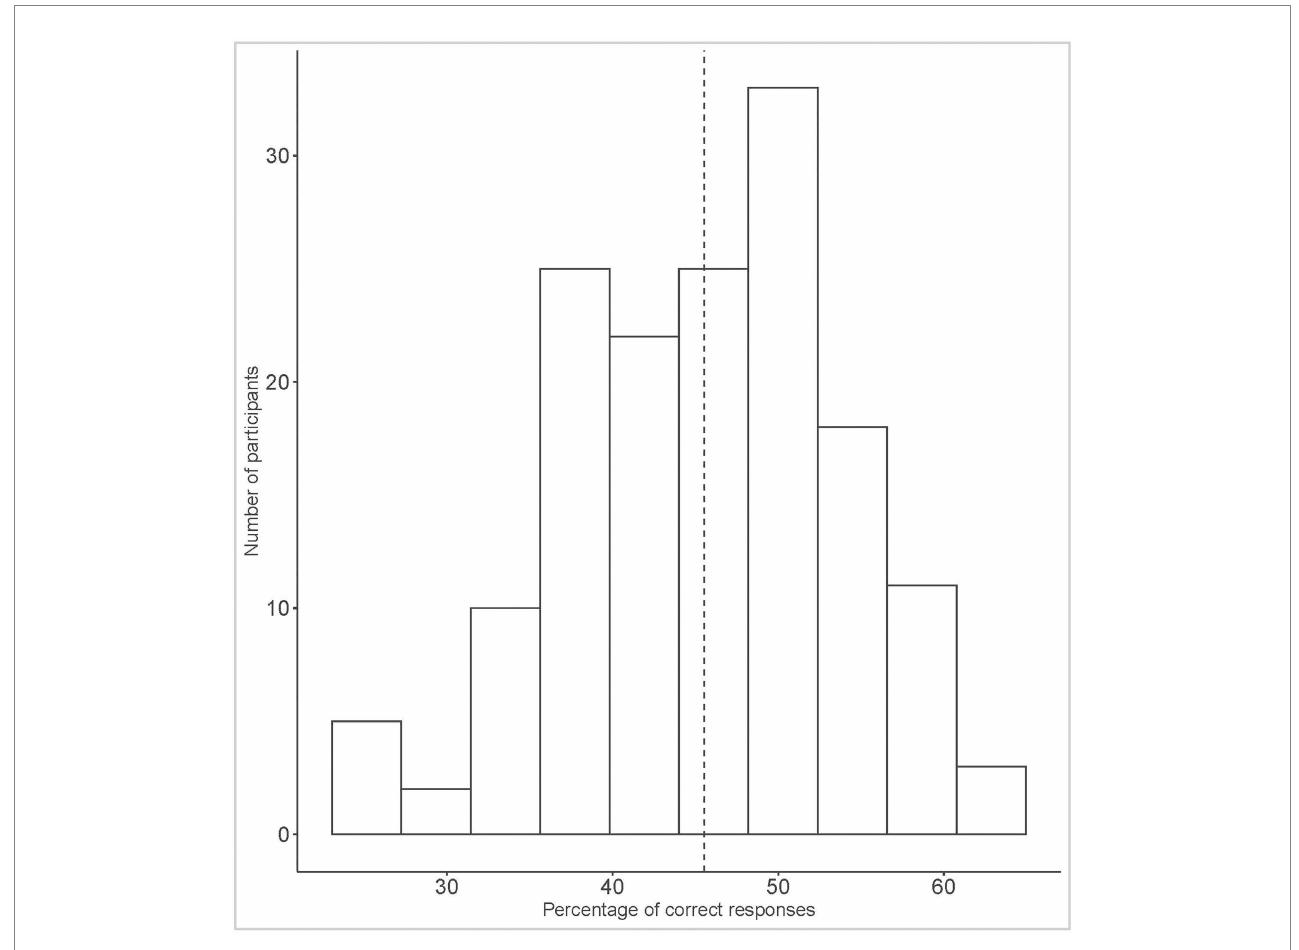
FIGURE 2 Distribution of percentage of correct responses in our sample ( N =